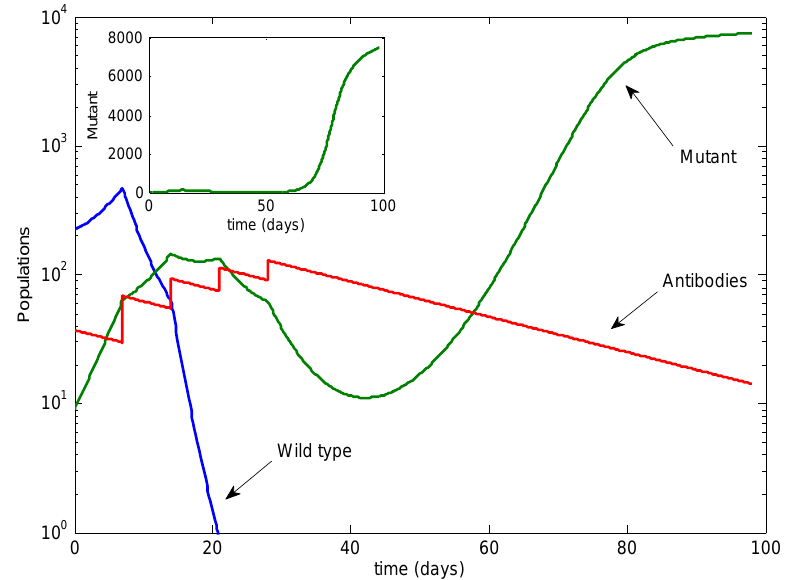
Figure 4. The case with two additional infusions. The mutant rebounds after the infusions stop. Additionally, we added infusions on Days 35 and 42, for a total of seven doses. See Figure 5. In this case, the mutant was also eradicated, eventually falling below 1 virus particle per horse, shortly after the last antibody infusion. In this case, the mutant peaked at only 150 viral particles.